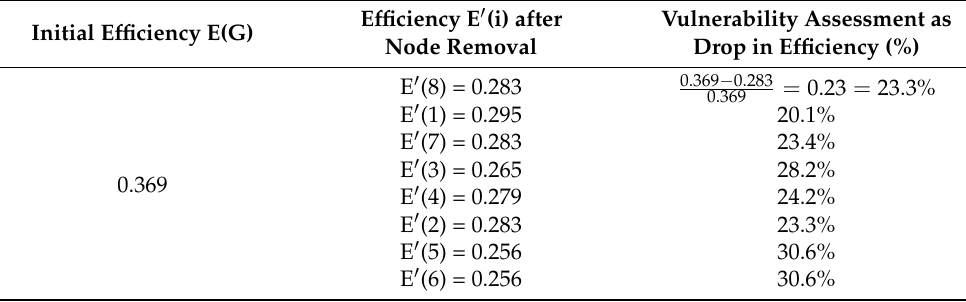
Table 10. Case study vulnerability assessment as drop in efficiency for every Node